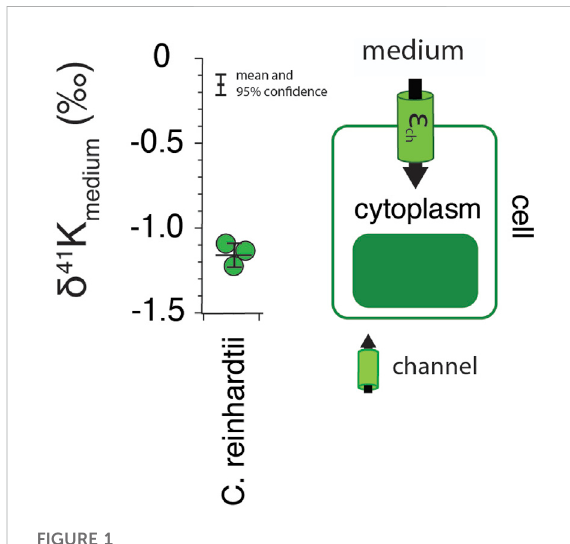
FIGURE 1 The difference in δ 41 K values between external and intracellular K + in growth experiments of C. reinhardtii and a diagramofK + transportinsingle-celledalgaegrownunderoptimal conditions (See Methods) including major fl uxes (F in ), transport machinery, and K isotope effects ( ε in ). p = 4.5 × 10 − 5 by one-way ANOVA in Matlab.